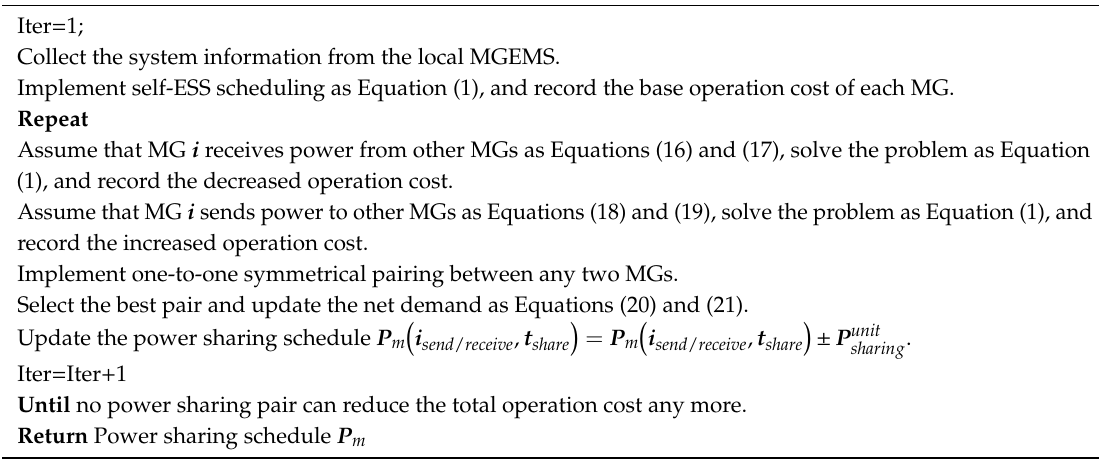
Algorithm 1 : Proposed power sharing algorithm for